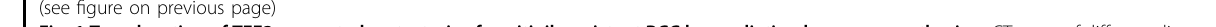
Fig. 1 Translocation of TFE3 promoted metastasis of sunitinib-resistant RCC by mediating lysosome synthesis. a CT scans of different disease stages from a ccRCC patient: sunitinib sensitive stage, one month after radical nephrectomy, new metastatic lesions occurred in left lymph node by 4 years ’ sunitinib treatment (from left to right). b Heat map of TMT proteomics from cancer tissues from different disease stages. c GO functional annotation analyzed the up-regulated proteins and the most differentially expressed proteins were enriched in the lysosome. d GO functional annotation analyzed the down-regulated proteins and the most differentially expressed proteins were enriched in CAMS, ECM receptor interaction, and focal adhesion. e Representative images of hematoxylin-eosin (H&E) staining and TFE3 staining by immunohistochemical (IHC) in sunitinib sensitive tissues and sunitinib resistant tissues. Scale bar, 100 μ m and 400 μ m. f Representative TEM images of lysosome (red dotted circle) in sunitinib sensitive tissues and sunitinib resistant tissues Scale bar 50 μ m. Higher magni fi cation insets showed the autophagosome (yellow) was engul fi ng the ER fragment (blue) in sunitinib-resistant tissues compared with sunitinib-sensitive tissues. Scale bar 5 μ